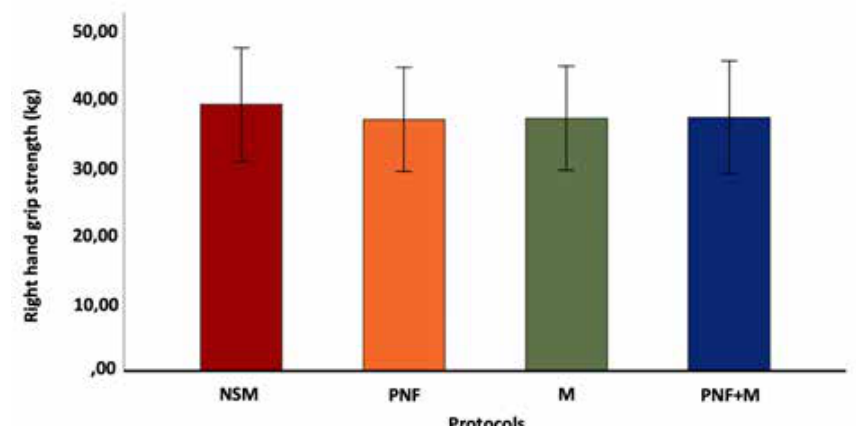
Figure 3. Right hand grip strength performance of four warm up and stretching protocols